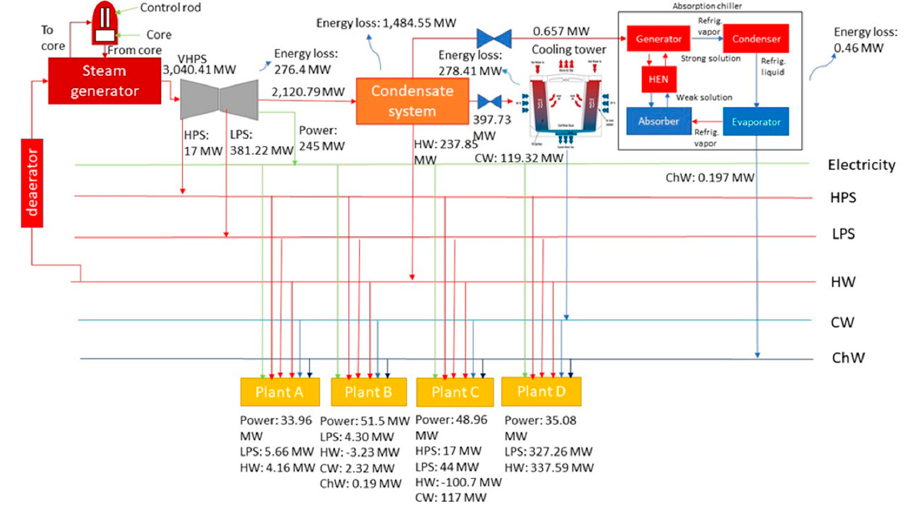
Figure 9. Final network for a PWR as a trigeneration system without integration.